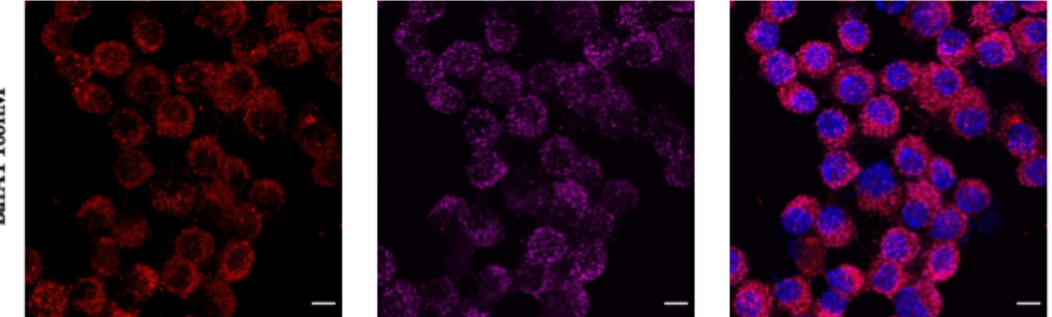
Figure A4. Positive and negative controls for autophagy. Cells were treated with the autophagy inductor Rapamycin 1 µM for 2 h, and with the autophagy inhibitor Bafilomycin A1 (BafA1) 100 nM for 4 h. Bars, 10 µm.